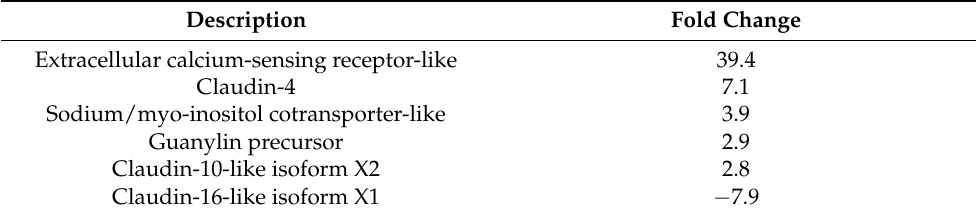
Table 4. Genes associated with osmoregulation that are differentially expressed in non-viable larvae in comparison with viable larvae in European eel Anguilla anguilla . Both groups represent larvae samples taken 1 dph, after which non-viable larvae survived less than 3 dph while viable larvae survived for at least a week up to 22 dph.